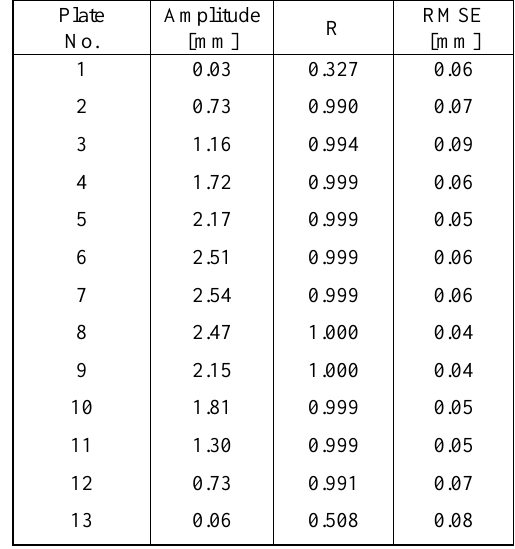
Table 6. Estimated amplitude, Pearson’s coefficient, and root mean squared error for all plates using medium